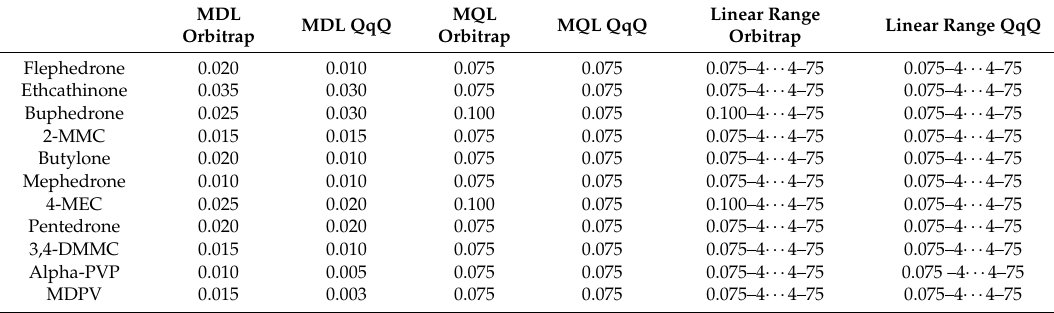
Table 4. Linearity in ng of cathinones, MDLs, and MQLs in ng g − 1 for Orbitrap and QqQ for the determination of synthetic cathinones in